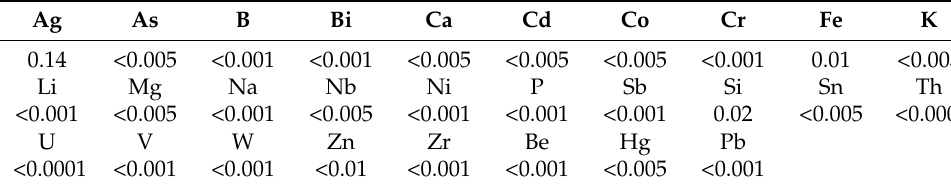
Table 1. Impurity composition of ultra-high purity Cu-0.1Al (wt-ppm).